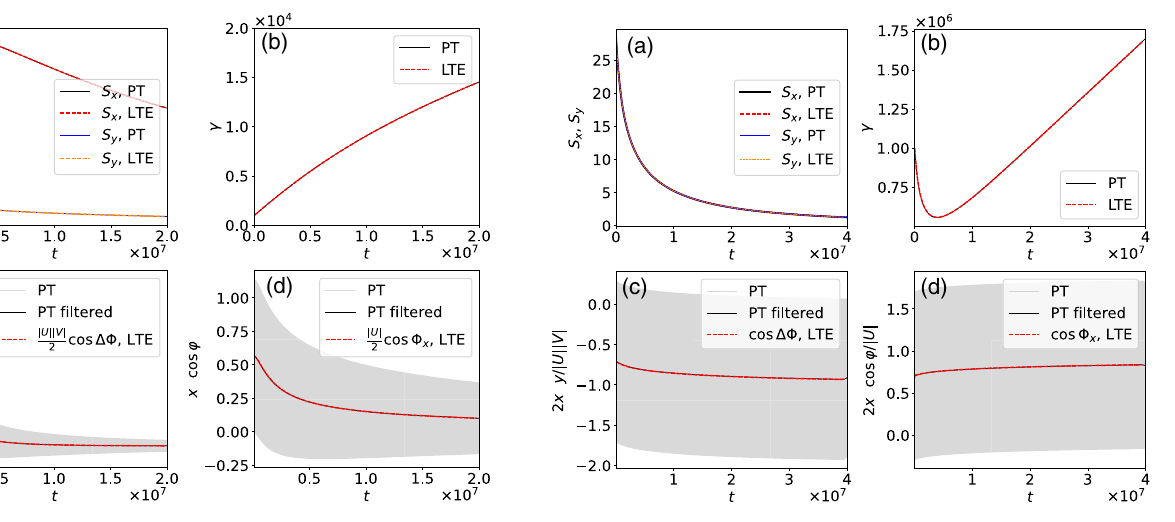
FIG. 4. The numerical comparison of the LTEs and the original equations solved by PTracker in the RR dominant regime. S ¼ S x - y plane is an oblique x y , thus the particle trajectory in the ellipse. (a) S x and S y decrease at the same rate. (b) γ initially decreases with time because the longitudinal RR damping is stronger than the acceleration. Later the RR damping becomes weaker due to the decrease of S x and S y , and γ increases. (c) and (d) show the same treatments as in Figs. 1(c) and 1(d), but the oscillation amplitudes are divided so that the changes of ΔΦ and Φ ΔΦ is between π = 2 and π , thus ΔΦ gradually x are clearer. approaches π .